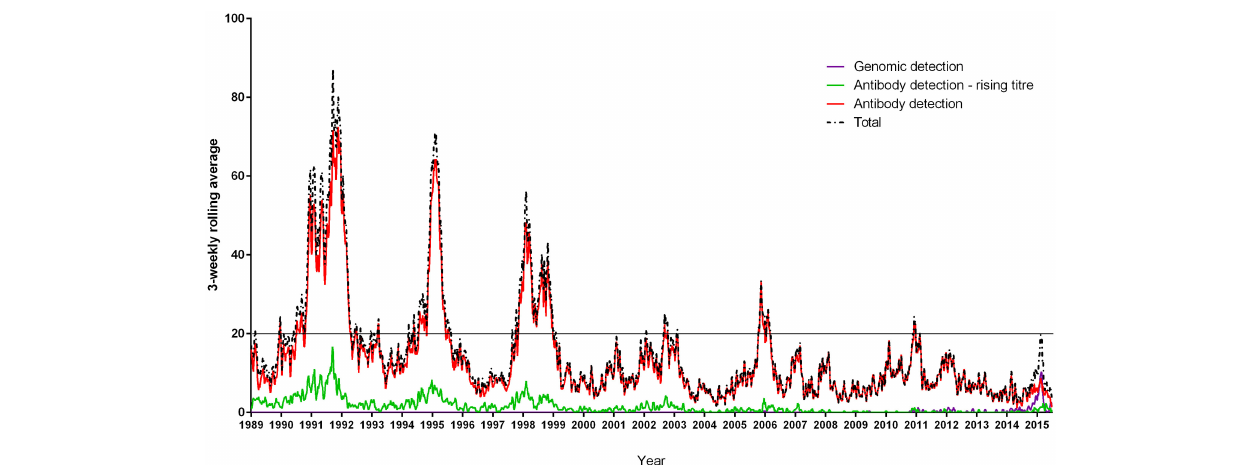
2 years (1991–1992, 1994–1995, 1998–1999, 2001–2003, 2005–2006, 2011, 2015). National reporting categories include antibody detection and antibody-detection rising titre. A rising titre is defined as a four-fold increase in detectable anti- Mycoplasma pneumoniae antibody level.